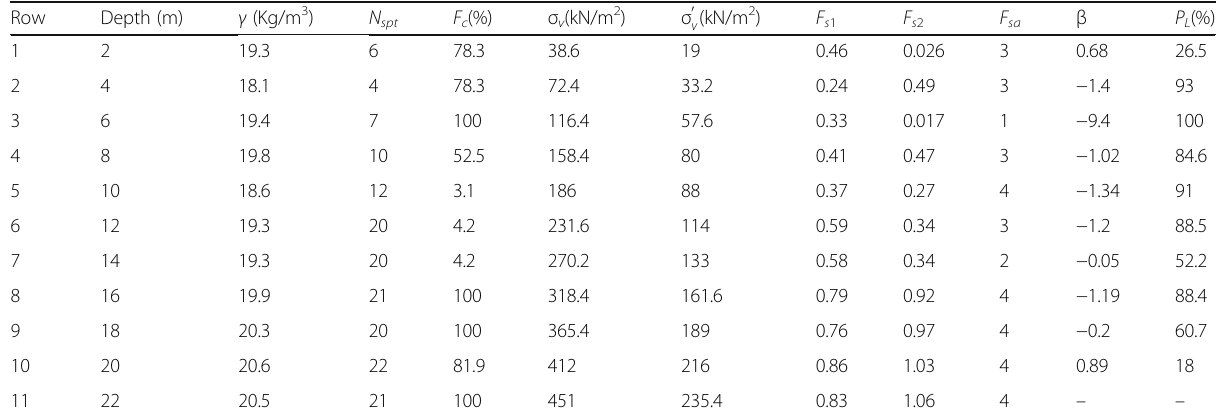
Table 2 The typical bore log data in Babol